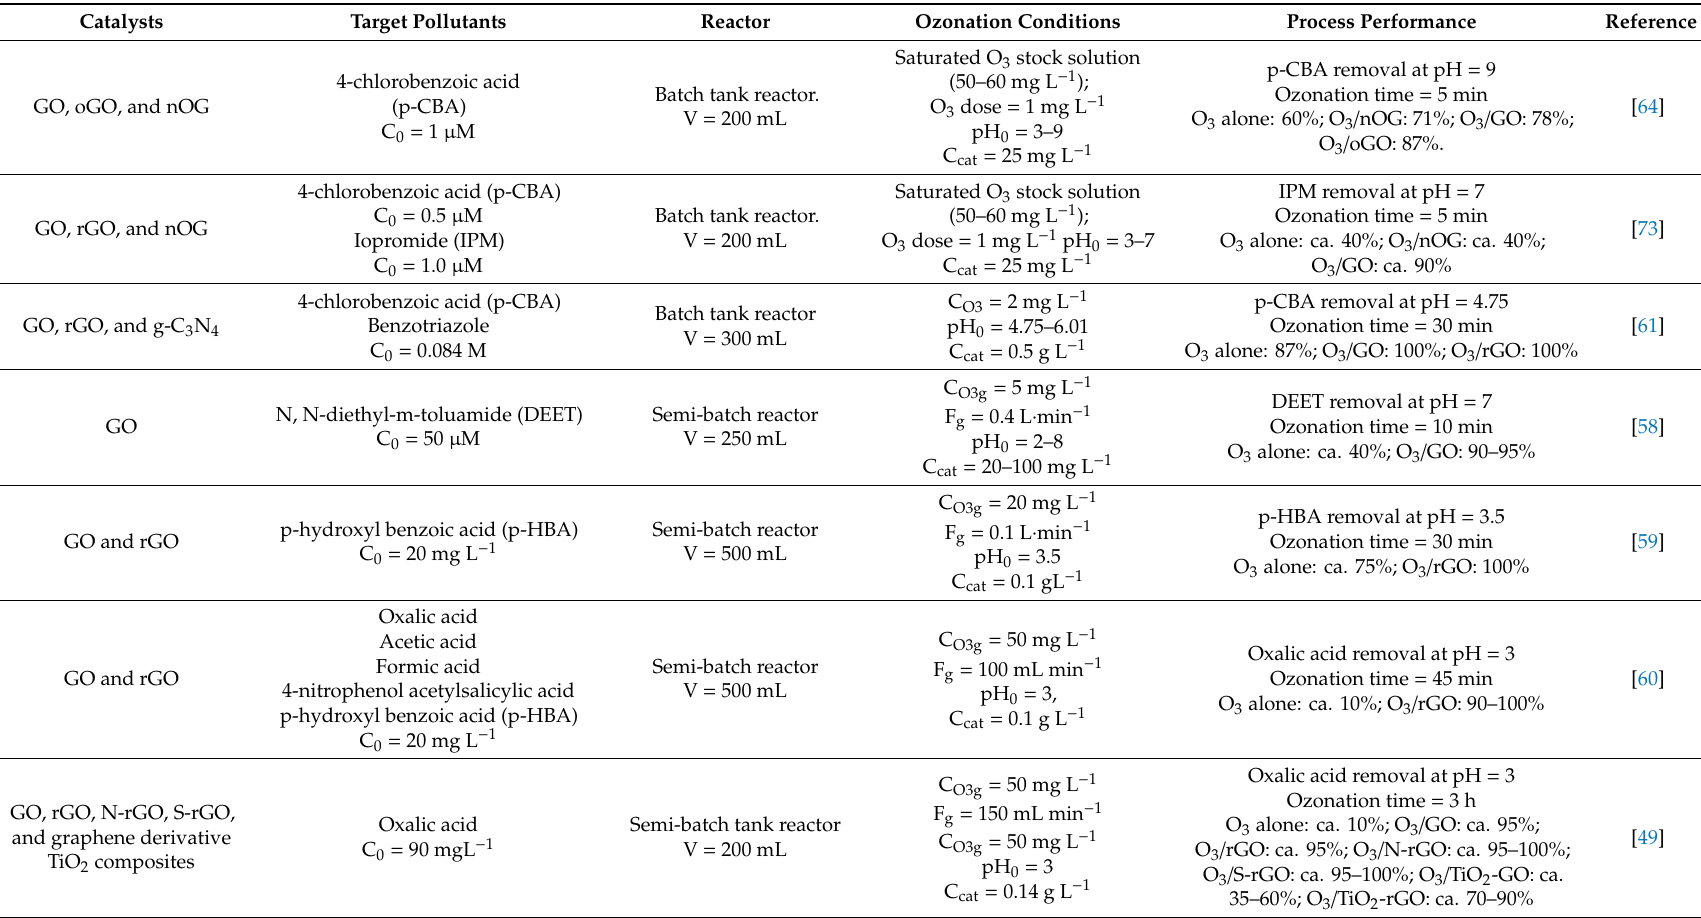
Table 2. Works on graphene-based catalysts used in catalytic